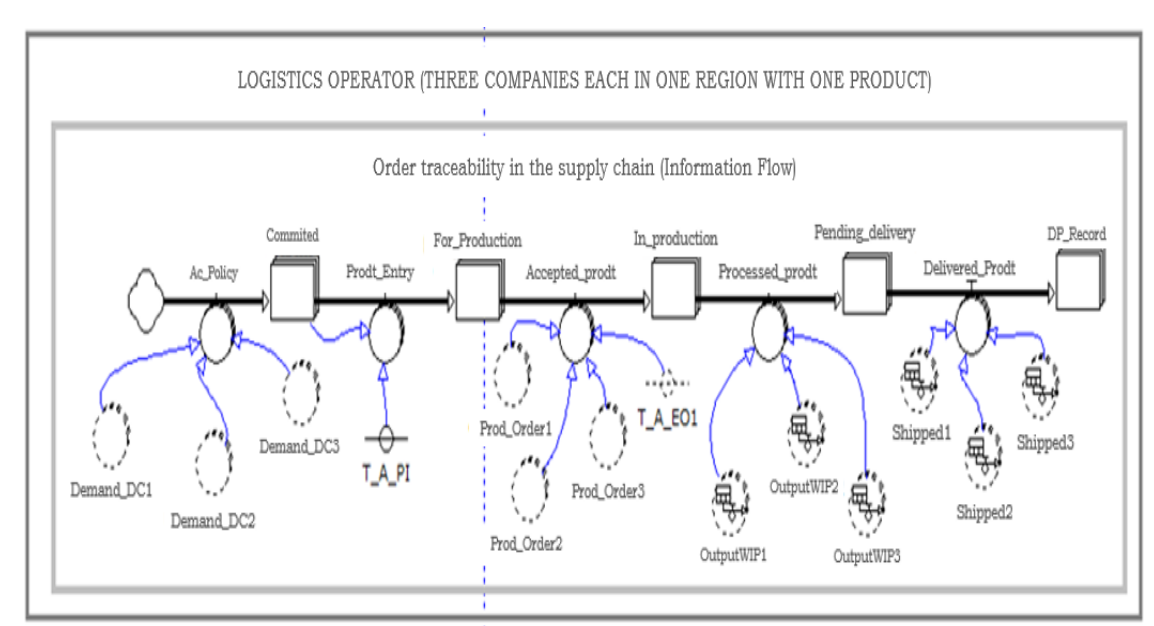
Figure 7. SC traceability — scenario 1: own elaboration. Evolution software. Thirdly, the SC of region 1 produces a single product and meets the demand of the three regions. The supplier is maintained with a single raw material as in the base model; consumption is constant because it is the same product (Raw_Mat_Quant), as seen in the supplier link in Figure 8, which is repeated in each of the regions.